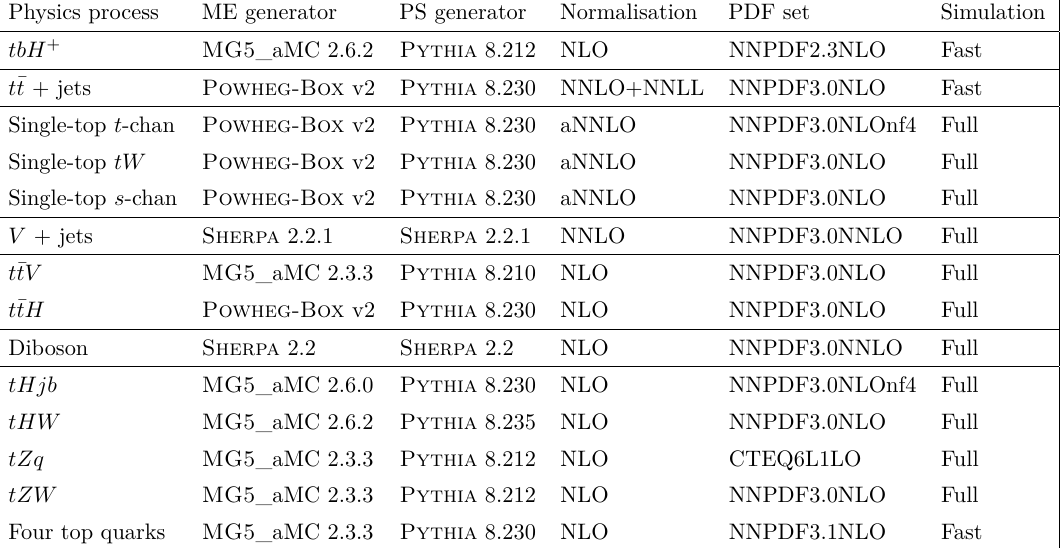
Table 1 . Nominal simulated signal and background event samples. The ME generator, PS genera- tor and calculation accuracy of the cross-section in QCD used for normalisation (aNNLO stands for approximate NNLO in QCD) are shown together with the applied PDF set. Either Sherpa 2.2.1 or Sherpa 2.2.2 was used for different diboson contributions. The rightmost column shows whether fast or full simulation was used to produce the